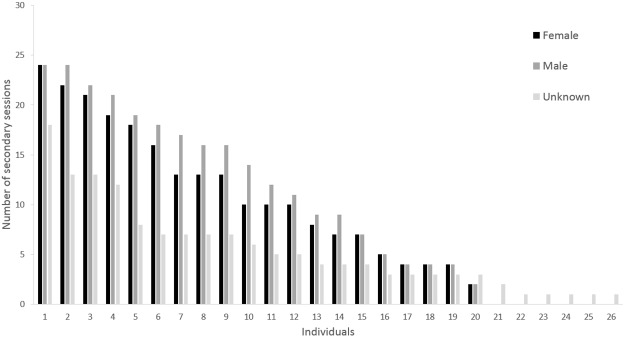
Distribution of the number of secondary sampling sessions (months) during which each male, female and unknown-sex individual was sighted (total number of secondary sampling sessions = 30).